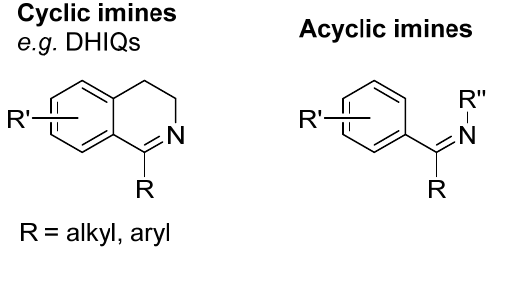
Figure 6. General structures of common imine